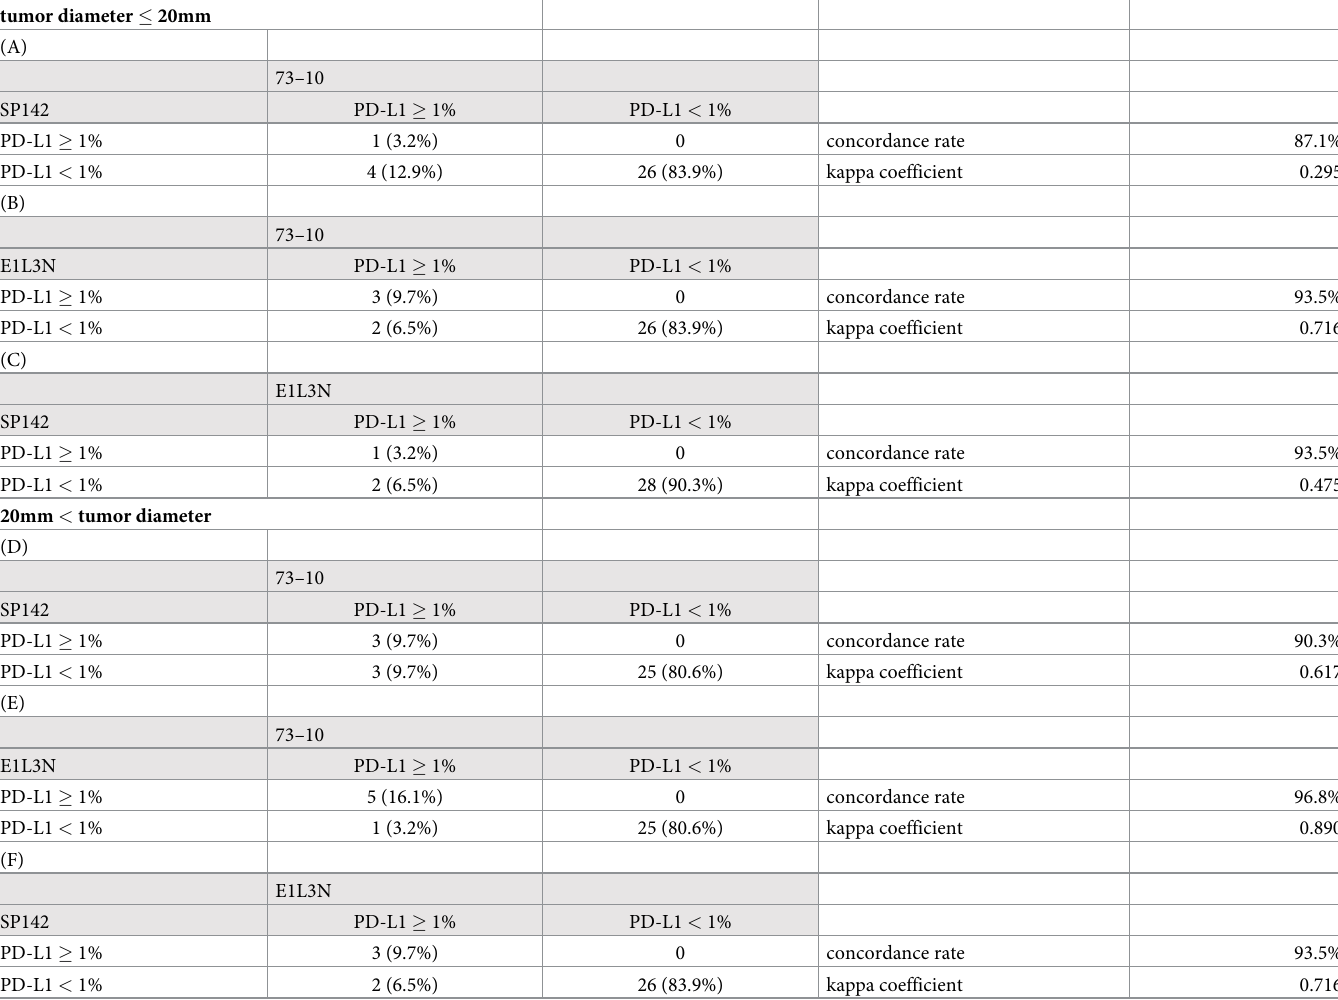
Table 7. Comparison of PD-L1 expression on TCs by 73–10, SP142, and E1L3N assays in tumor diameters.